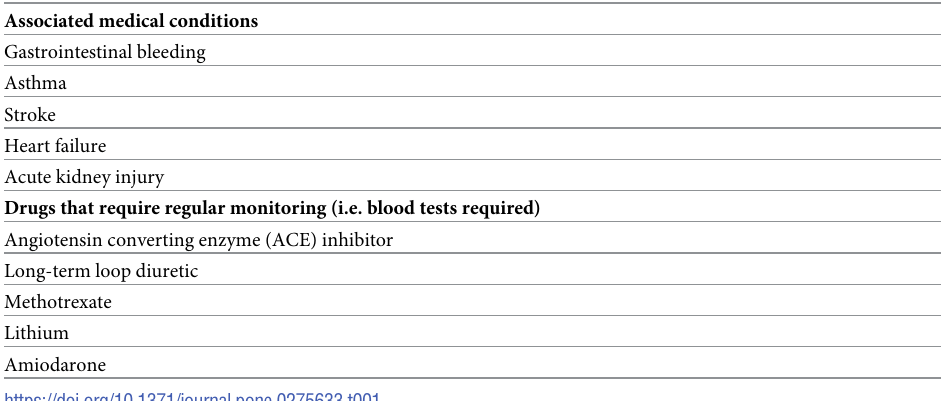
Table 1. Medical conditions and drugs associated with PINCER prescribing indicators